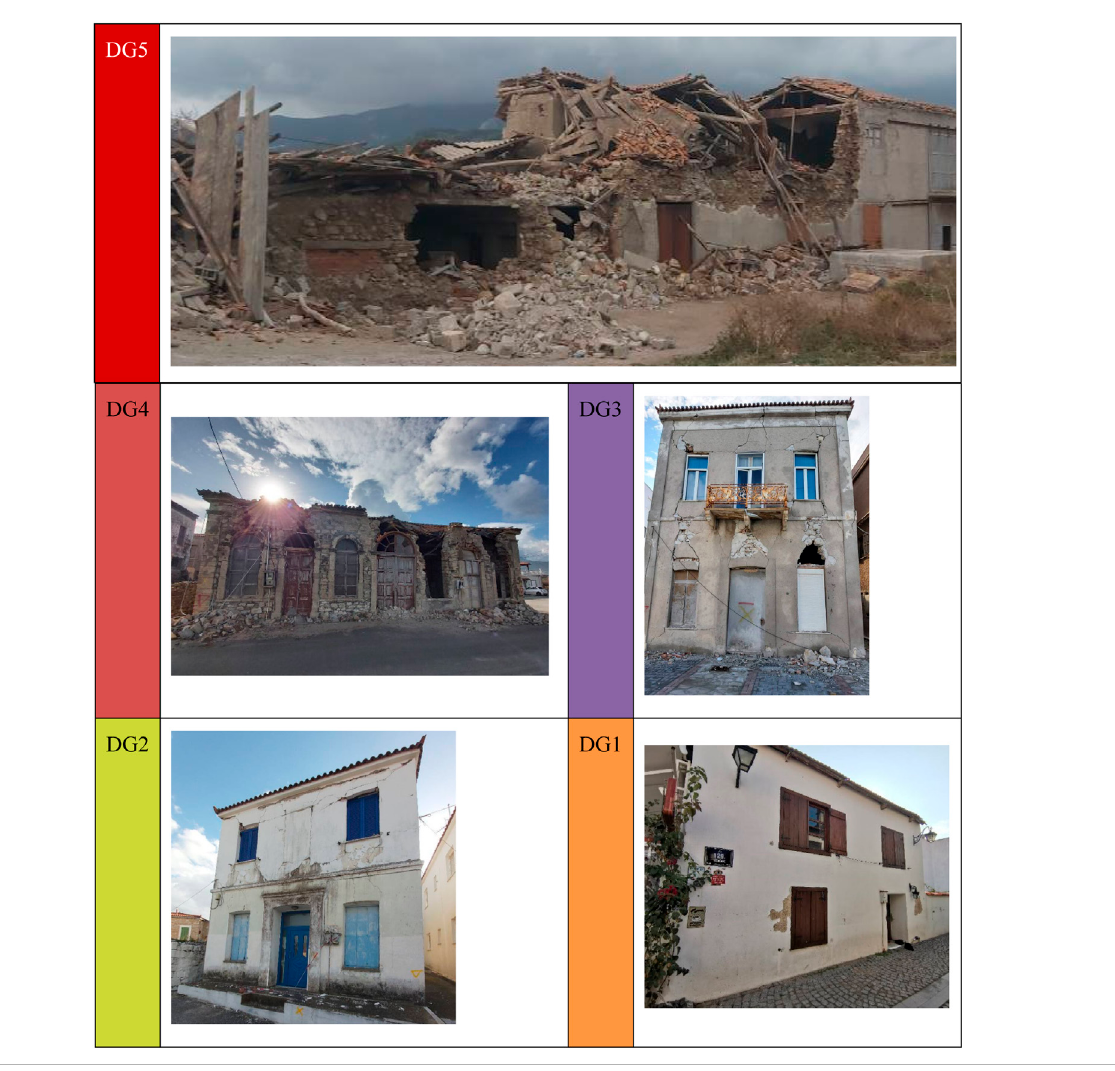
TABLE 4 | Examples of masonry structures at different damage classes (DG1 in S ığ ac ı k, DG2-5 in Samos).